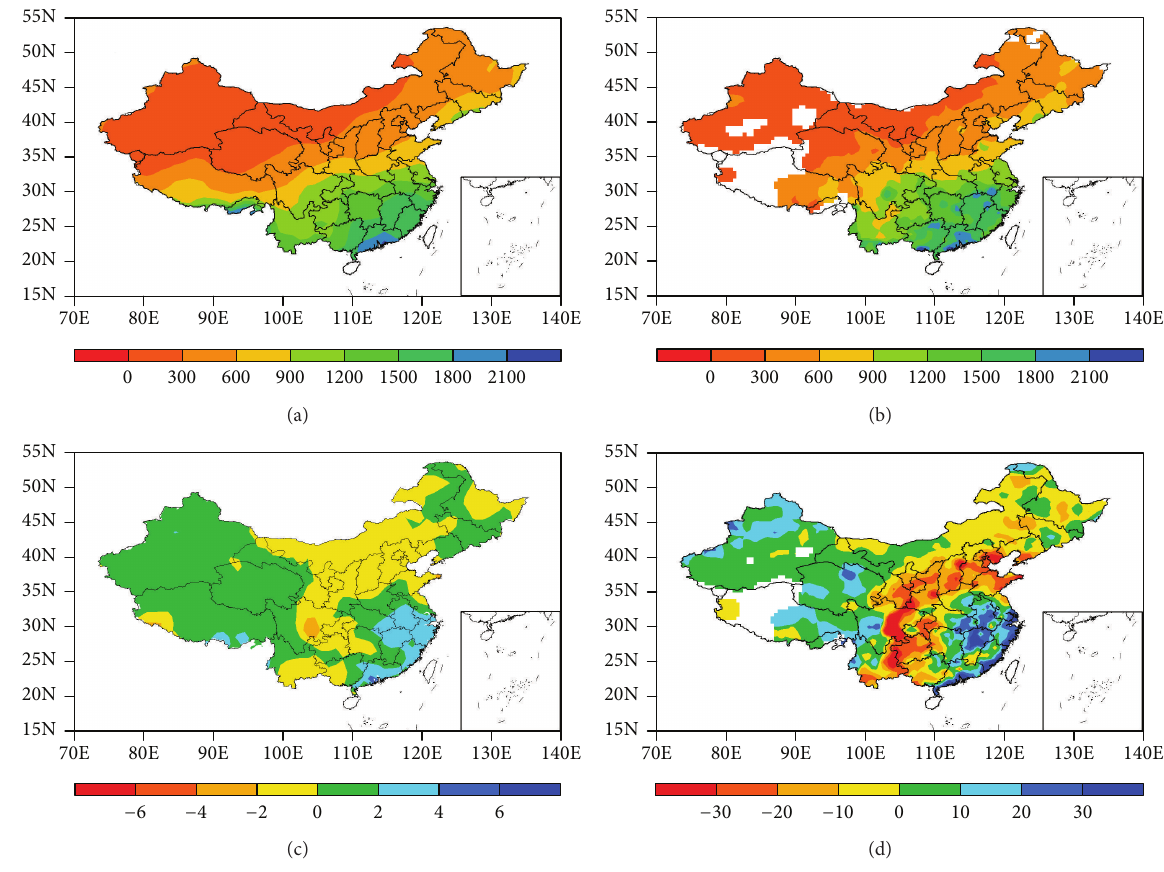
Figure 1: The intercomparison between Princeton precipitation and measured precipitation of 1961–2010. (a) Princeton annual mean precipitation (unit: mm); (b) ground measured annual mean precipitation (unit: mm); (c) Princeton annual precipitation variation linear trend (unit: mm/10a); and (d) ground measured annual precipitation variation linear trend (unit: